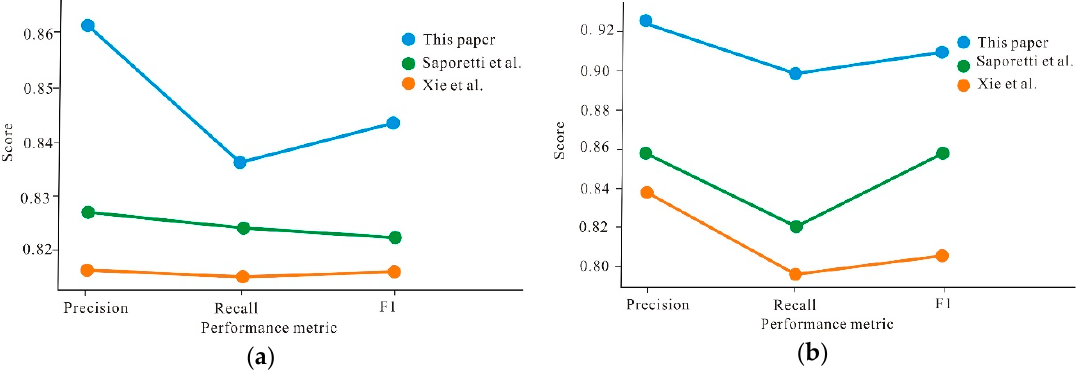
Figure 7. Point plots for results produced by the proposed approach compared with references. ( a ) The DGF dataset; ( b ) the HGF dataset. DGF dataset; ( b ) the HGF